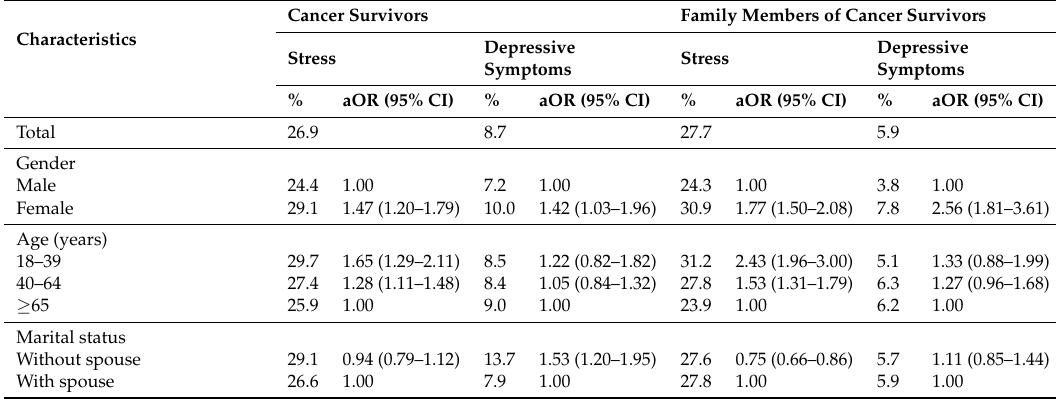
Table 3. Stress and depressive symptoms by characteristics in cancer survivors and family members.